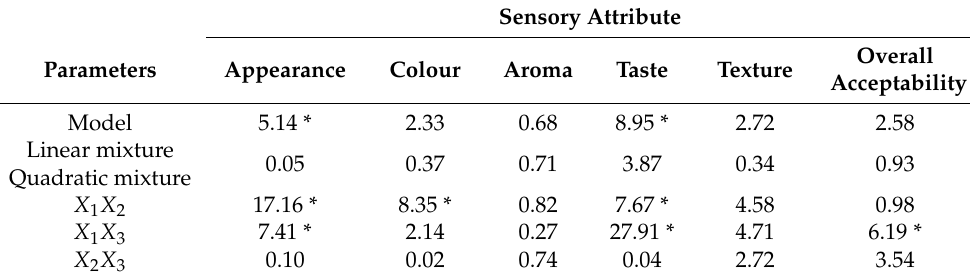
Table 4. F-ratio from quadratic mixture model for instant egusi